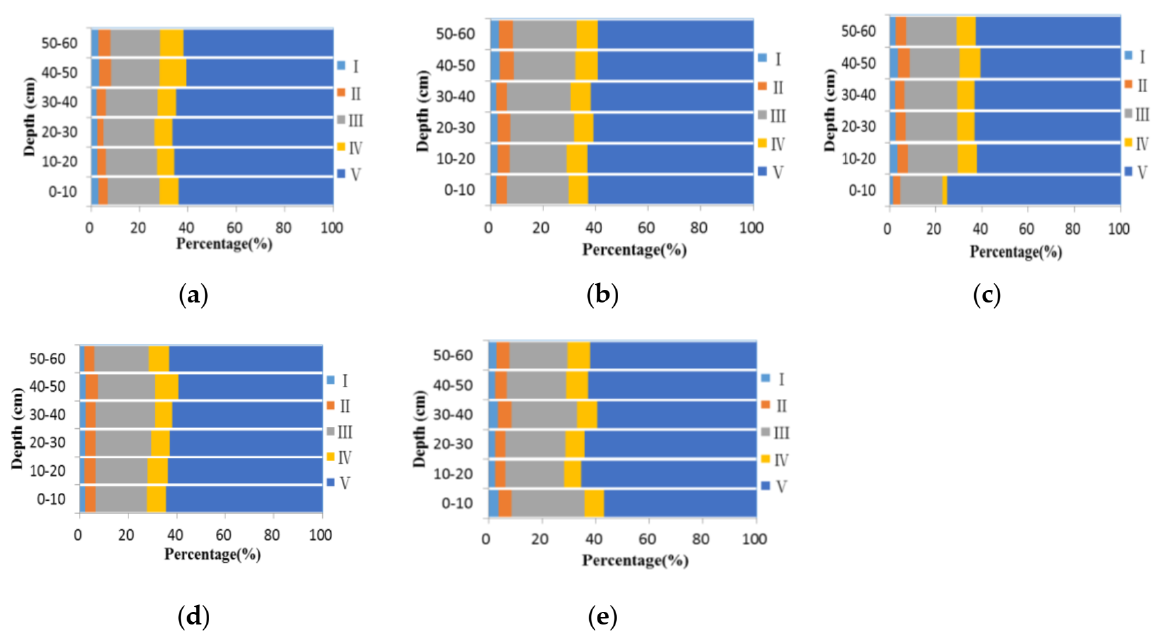
Figure 1. Fluorescence characteristics of WSOC after six years of fertilization (I, tyrosine-like sub- stance; II, tryptophan-like substance; III, fulvic acid-like substance; IV, soluble microbial byproduct- like substance; V, humic acid-like substance): ( a ) no fertilizer; ( b ) NPK; ( c ) BC; ( d ) NPK + BC; ( e ) N + BC. Table 3. The original data of the results in Figure 1